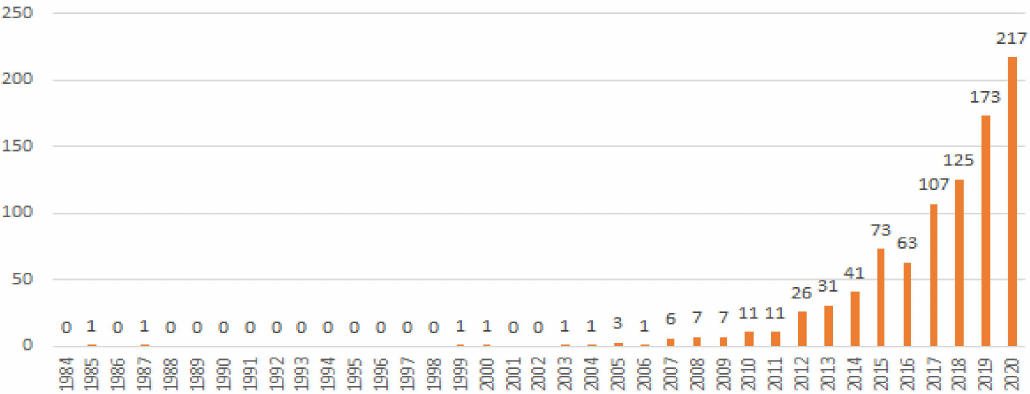
Figure 2. Relevant papers on BIM and building energy efficiency were published each year between 1985 and